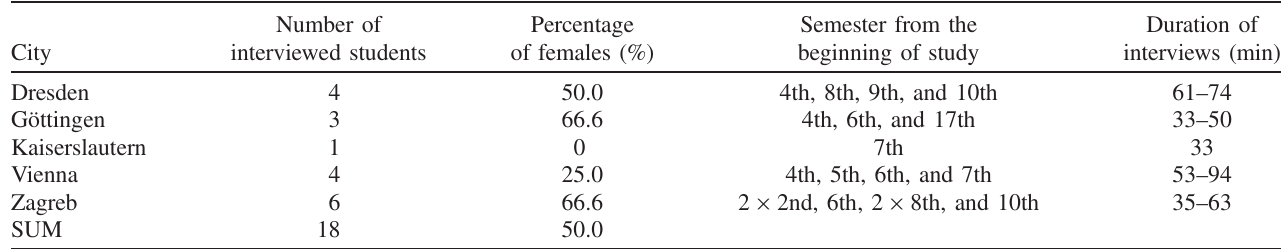
TABLE II. Information about the interview sample.